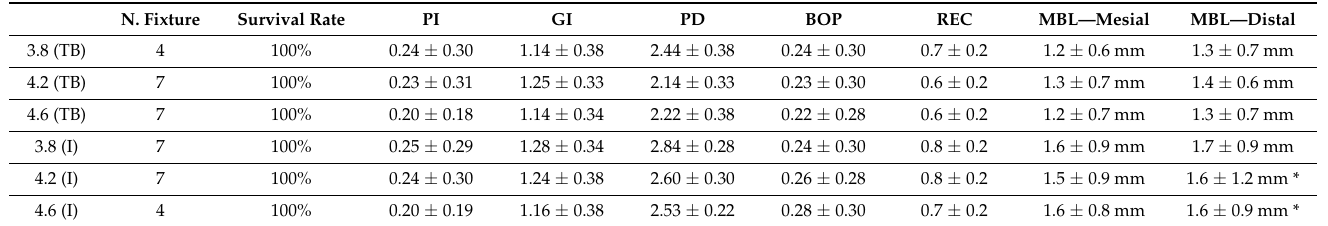
Table 2. Periodontal indices and MBL (marginal bone loss) measured mesial and